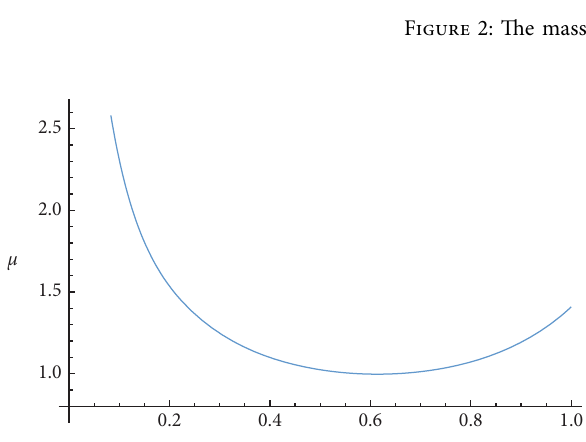
Figure 2: Te mass ratios μ